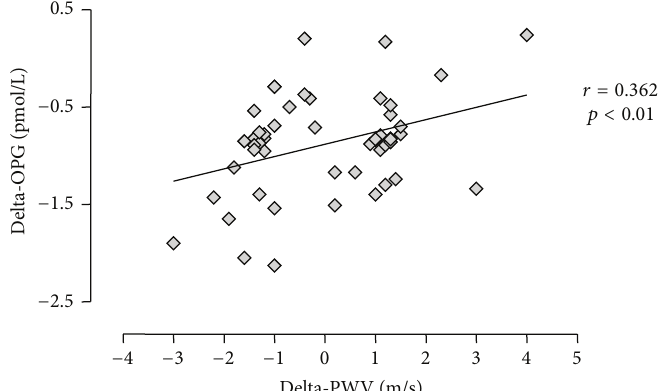
Figure 3: Correlation between change in PWV and change in OPG from baseline to 12 months in each patient. OPG: osteoprotegerin; PWV: pulse wave